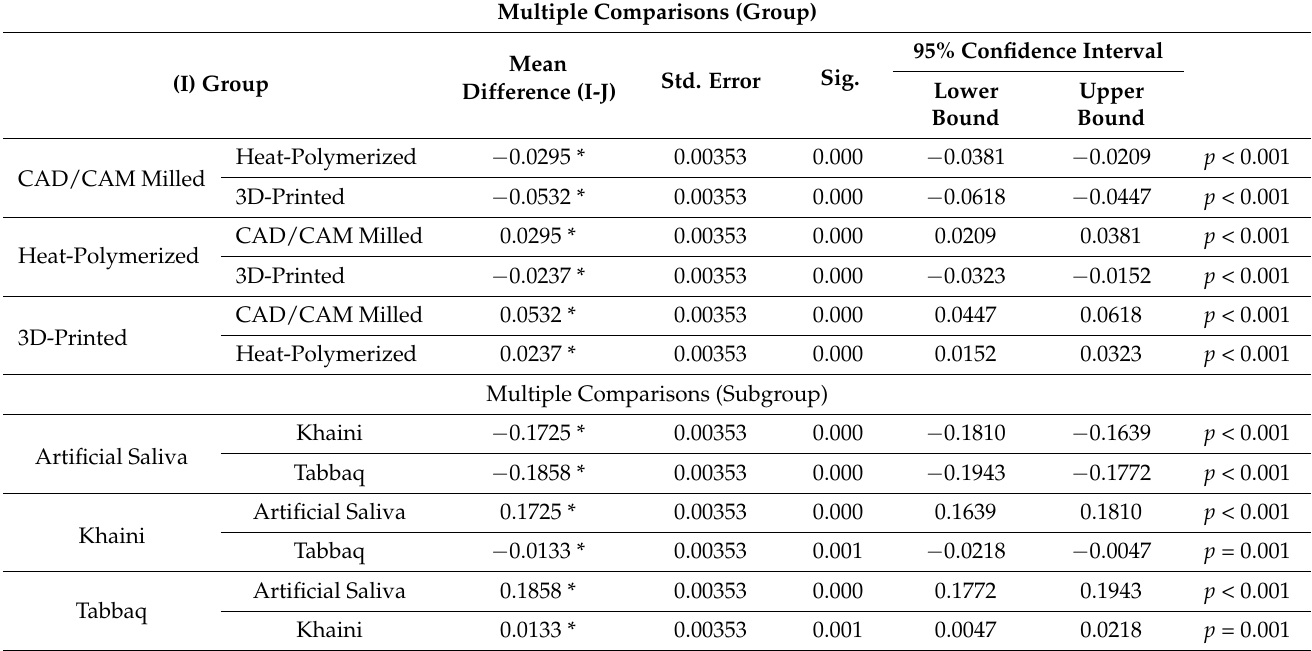
Table 5. Comparison between groups and subgroups to check differences in surface roughness change ( ∆ Ra) using post hoc Bonferroni